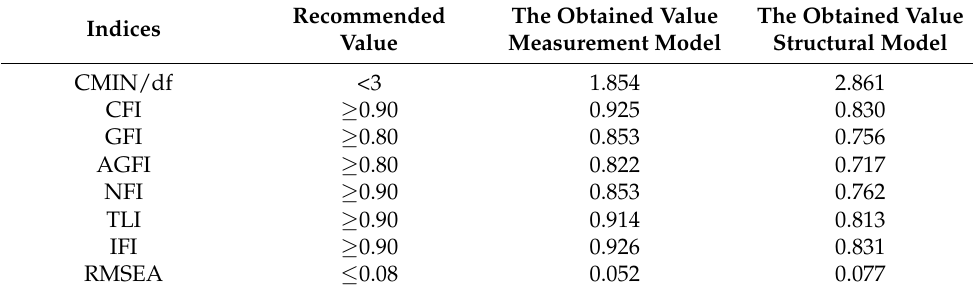
Table 5. Model fit results.